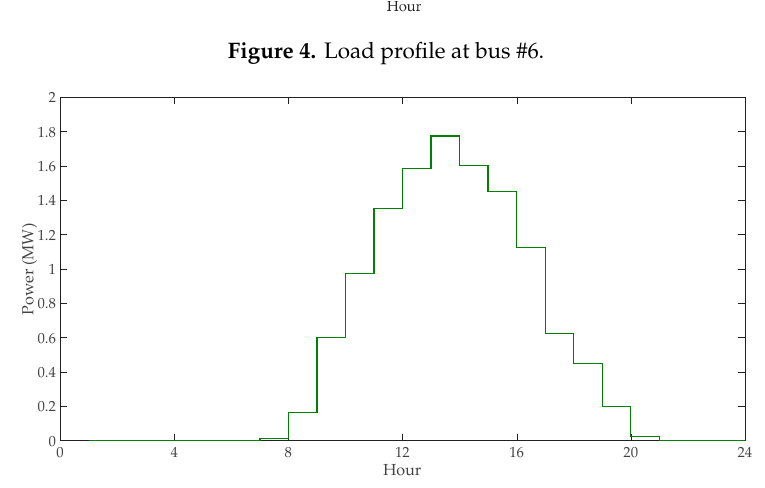
Figure 4. Load profile at bus #6.